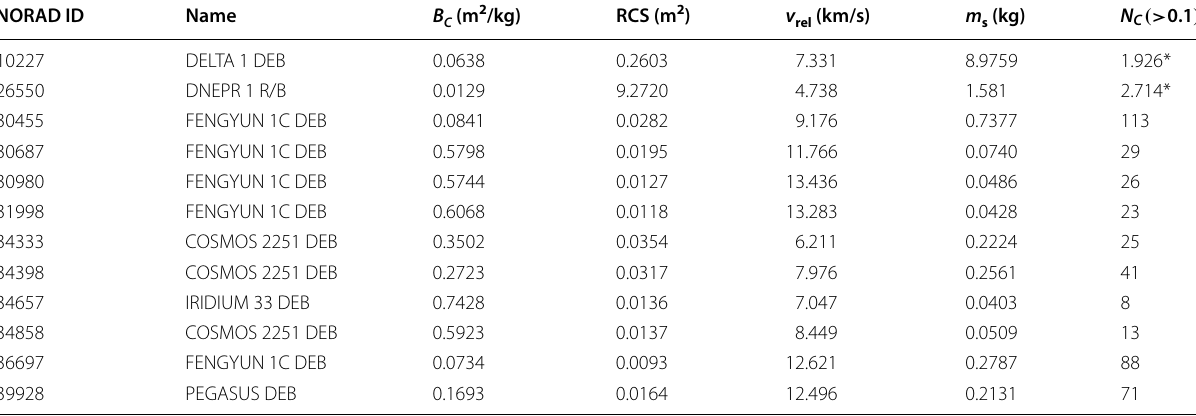
A ‘*’ indicates that the conjunction was catastrophic ( EMR ≥ 40,000 J/kg)